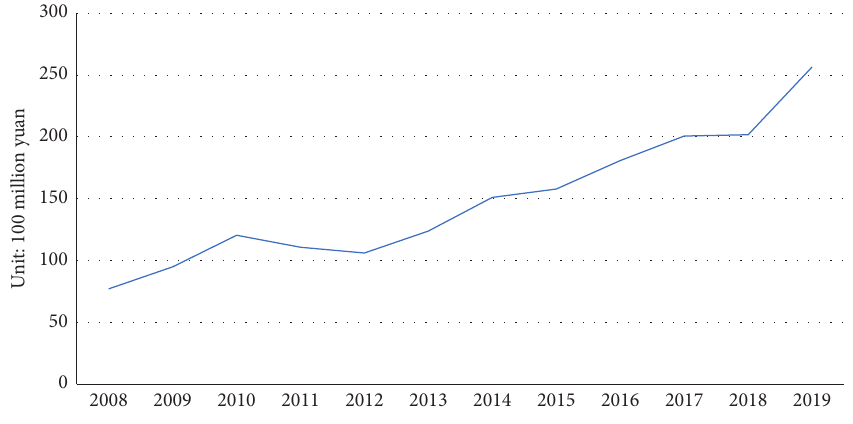
Figure 1: The chart of total output value of Hainan’s fruits from 2008 to